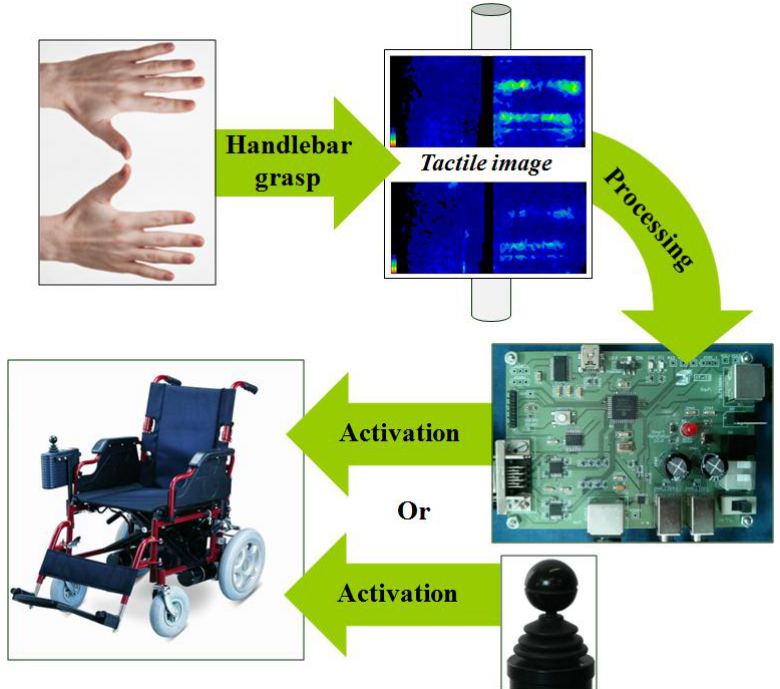
Figure 1. System